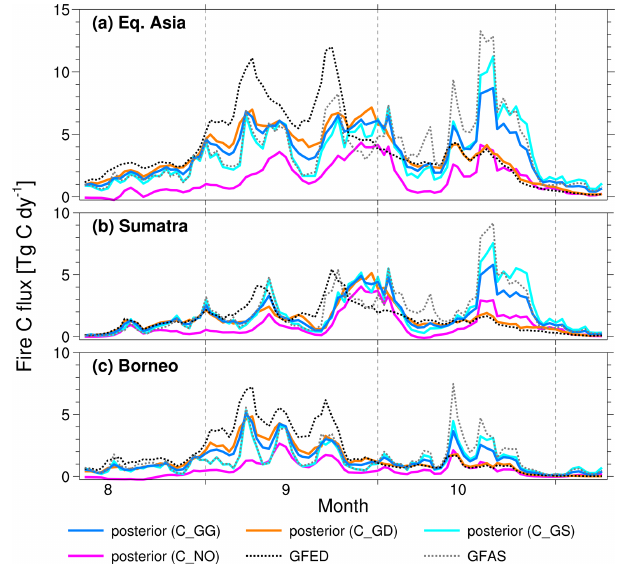
Figure 11. Time series of posterior and prior fire carbon emissions over the fire season (mainly, September–October) of 2015. The pos- terior fluxes of C_GG (blue solid), C_GD (orange solid), C_GS (cyan solid) and C_NO (magenta solid) are shown. Prior data of GFED (black dotted) and GFAS (grey dotted) are also